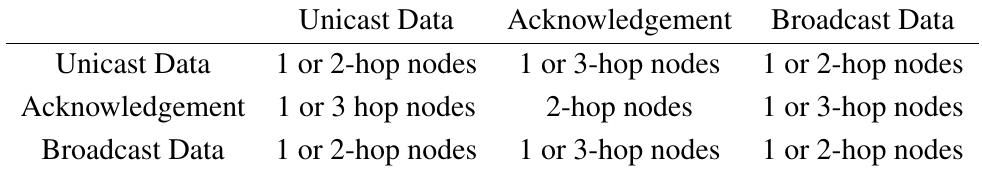
Table 1. Possible collisions in case of general application, broadcast and immediate acknowledgement.